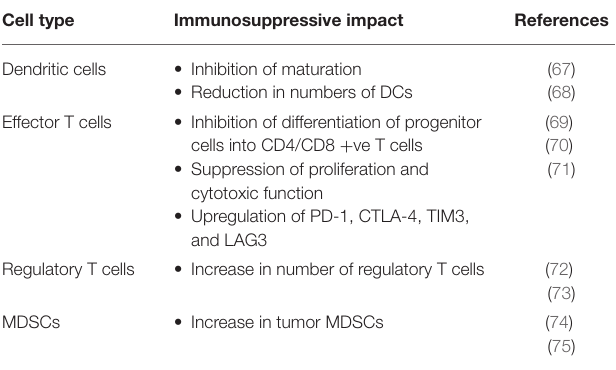
TABLE 5 | Selected immunosuppressive roles of